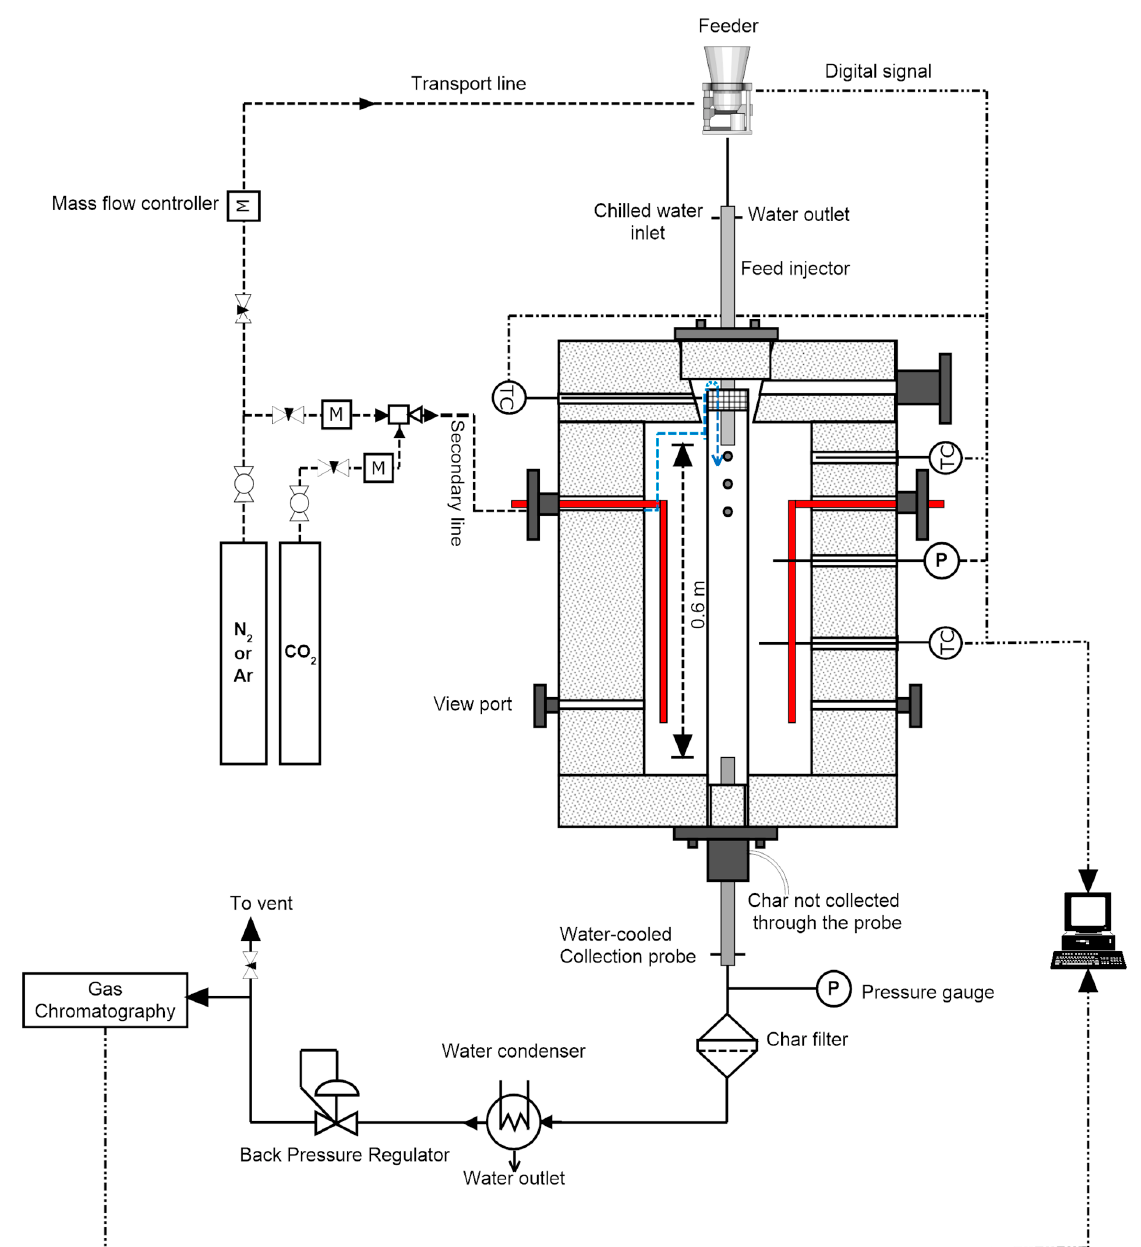
Figure 1 . Schematic of the high-pressure, high-temperature flow reactor. Figure 1. Schematic of the high-pressure, high-temperature flow